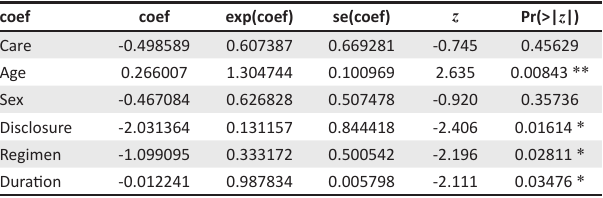
FIGURE 3: Kaplan–Meier survival analysis for retention in care among younger and older adolescents over TABLE 3: Cox proportional hazard regression model.